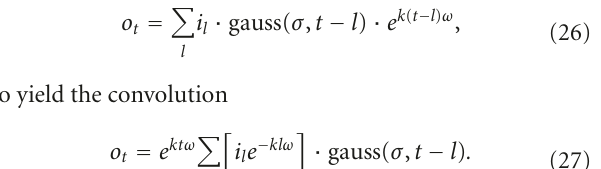
and b j di ff er only in the complex exponential (17), the result of (19) is